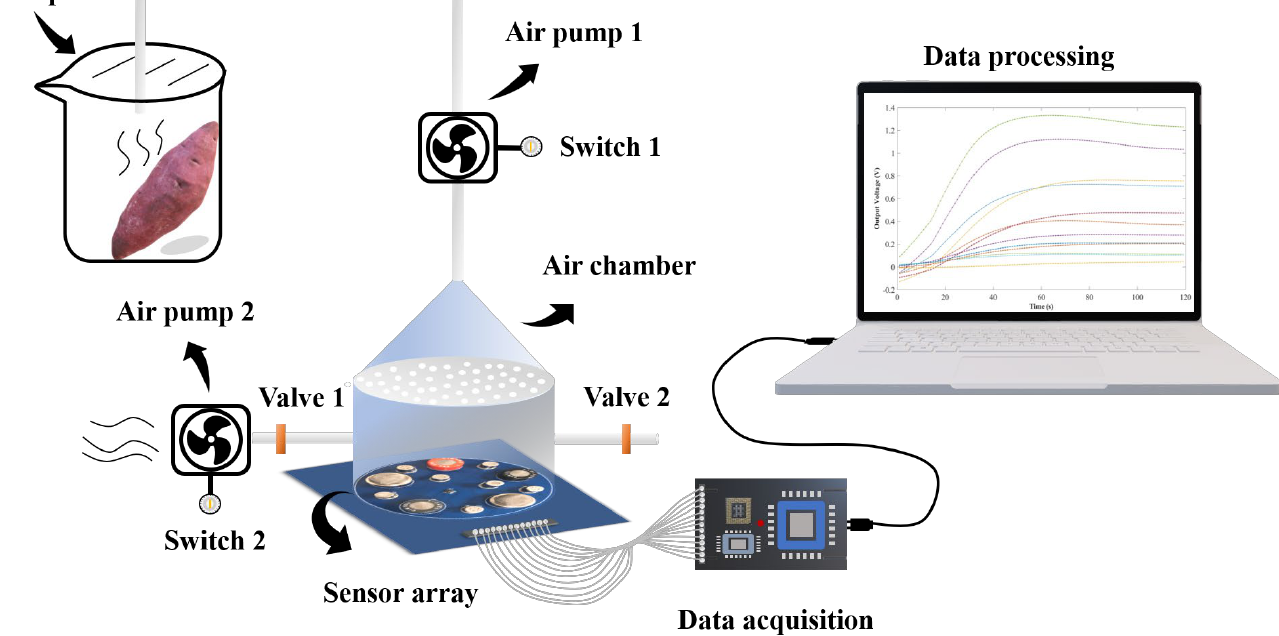
Figure 1. Composition and working principle of E-nose. A dehumidifier was installed in the room to control the humidity and keep the ambient humidity constant. The relative humidity in the air chamber during sample testing is shown in Table S2. Detection with E-nose referred to the method of Pang et al. [40], with appropriate modifications. The prepared sweetpotato samples were put into 500 mL clean and odourless beakers, which were then sealed and placed in a constant-temperature environment of 30 ◦ C for 15 min to obtain headspace gas. E-nose was preheated for 2 h in advance. When the sample was measured, the valves on both sides of the air chamber were closed, and air pump 1 was turned on. The headspace gas in the beaker was pumped out to the air chamber at a constant flow rate of 300 mL min − 1 for 90 s, then equilibrated for 30 s. After the sample was detected, sweetpotato and beaker were removed. The valves on both sides of the air chamber were opened, air pumps 1 and 2 were turned on at the same time, and the airflow rate was adjusted to the maximum. Fresh air filtered with activated carbon was pumped into the air chamber for 120 s for cleaning. When the response curve returned to the baseline, the experiment proceeded to the next sample detection. Thirty sweetpotato samples were detected at each time